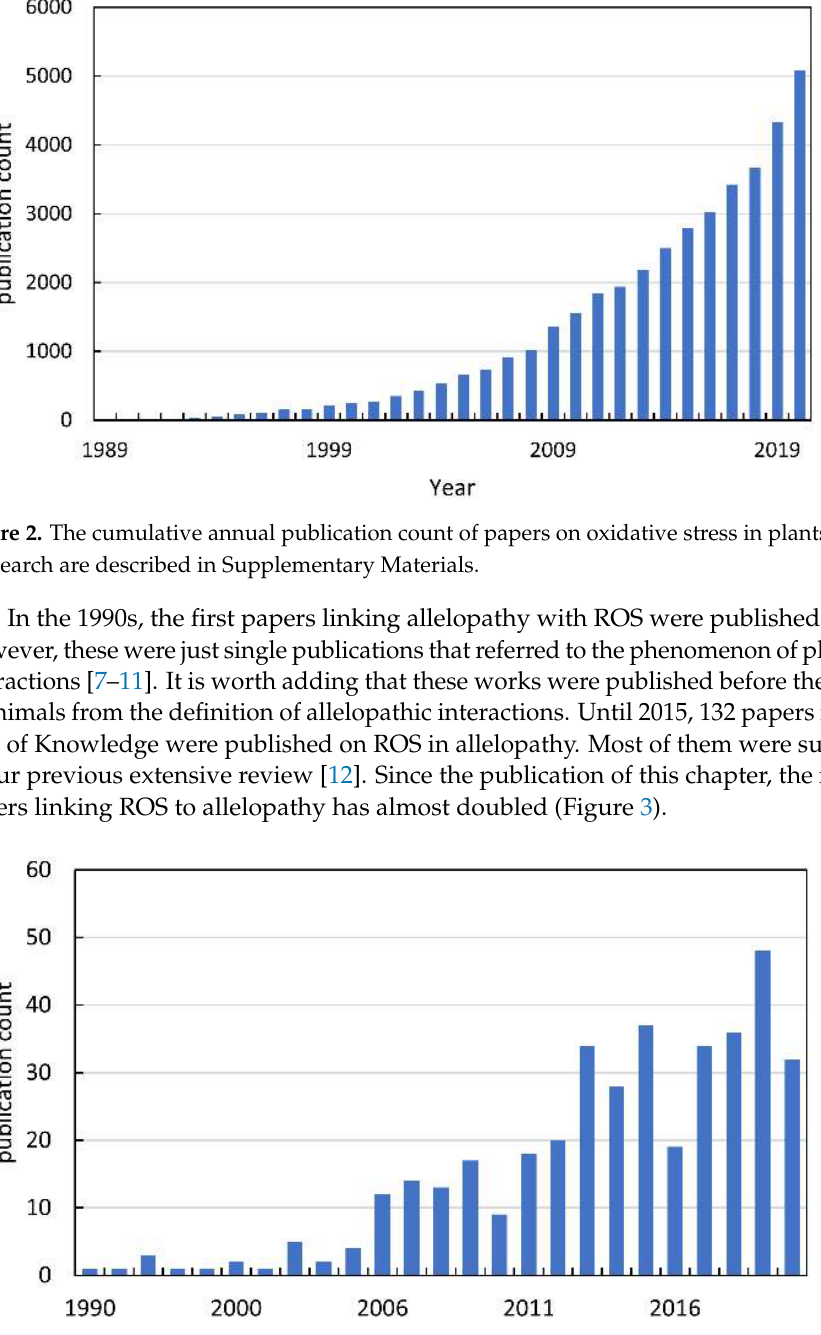
Figure 3. The cumulative annual publication count of papers on ROS in allelopathy. Details of the search are described in Supplementary Materials.